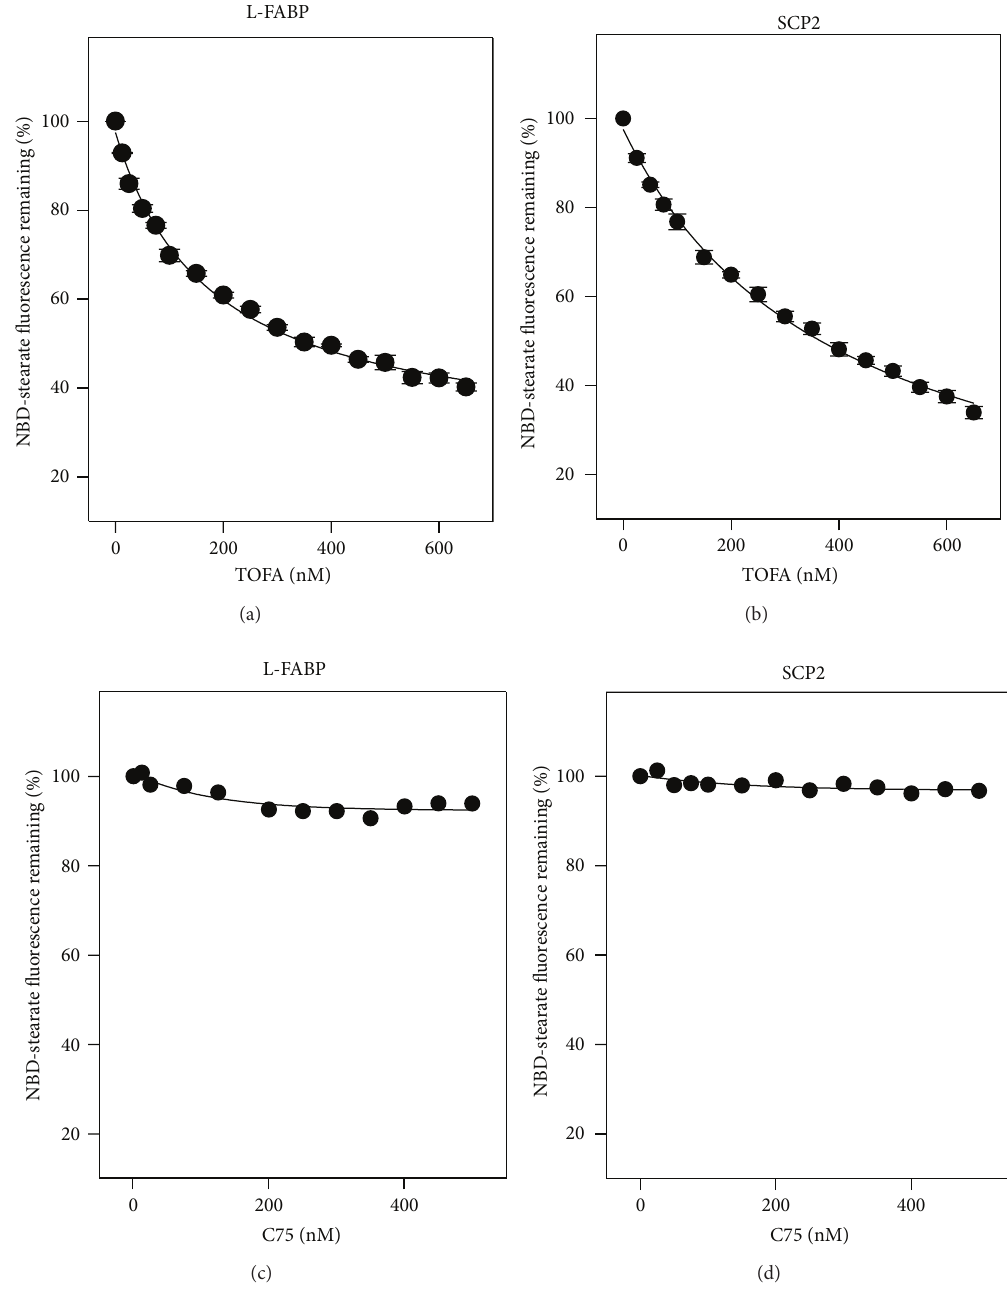
Figure 3: Displacement of L-FABP- and SCP2-bound NBD-stearic acid by TOFA (panels a and b) and C75 (panels c and d). NBD-stearic acid displacement assays were performed as shown in Methods. L-FABP or SCP-2 (25nM in 10mM phosphate buffer) was incubated with NBD stearate (40nM) for 12min at 24 ∘ C to obtain maximal fluorescence, then titrated with increasing amount of ligand. Mean ± SEM, 𝑛 = 3 .